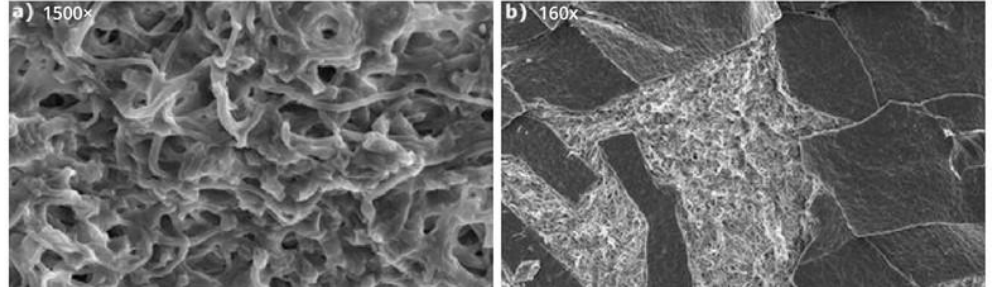
Figure 1. SEM microscopy of pre-formed biofilms of P. Ostreatus [17] Copyright 2017 Elsevier. ( a ) Compact 7 days old fungal biofilm showing hyphae cemented together with EPS matrix. ( b ) Fractured layer of EPS covering the surface of the fungal mat.